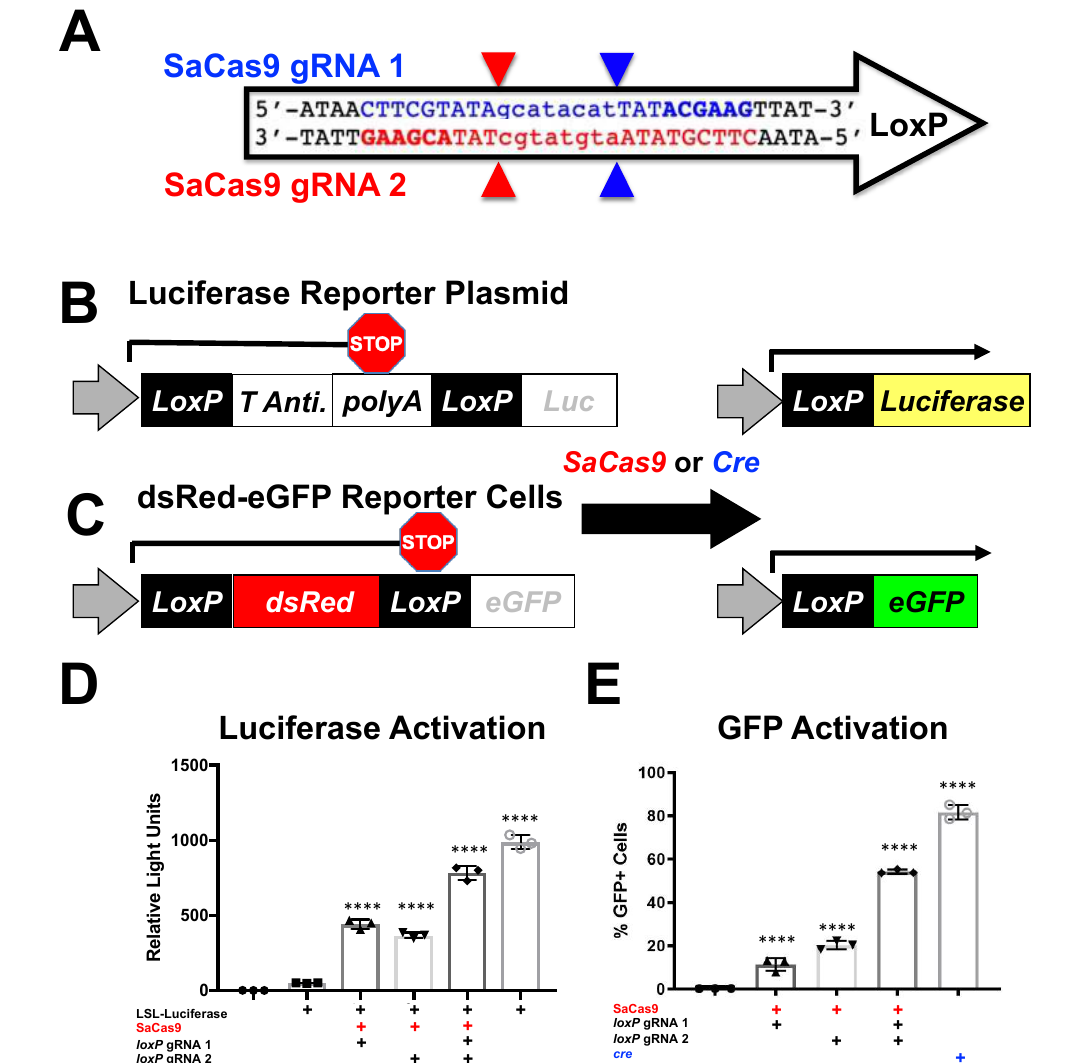
Figure 1. Gene activation through targeting lox P in vitro. ( A ) The lox P sequence is shown with key features and target sites for CRISPR SaCas9. The capitalized base pairs are the 13-base-pair palindromic regions flanking the 8-base-pair core that gives lox P its directionality. The gRNA 1 homologous strand to the guide RNA is depicted in light blue with the PAM-binding region in dark blue and bold letters and a triangle to indicate the cleavage site. gRNA 2 depicts the same in red. ( B ) This depicts the reporter plasmid p133, the LSL-Luc reporter plasmid used in D, and the general outcome when treated with SaCas9 with targeting lox P gRNAs or cre recombinase. ( C ) The lentiviral vector is used to make the Red/Green reporter cells used in ( E ) and similarly depicts the outcome when gene edited by SaCas9 or Cre. ( D ) Cells were plated into a 6-well plate and transfected at 60–80% confluency with Xfect and 2.5 µ g of the reporter plasmid was transfected to be targeted by cre or SaCas9. Groups were compared by one-way Anova and Tukey’s multiple comparison. Using this, all the groups were significant compared to other groups except between the untransfected control group and the P133 transfected group and between the individual gRNA treated groups; 95% confidence intervals are shown and the significance against the control is shown (n = 3). ( E ) The Red/Green HEK293 reporter cells were transfected with 5 µ g of plasmid. The single gRNA groups were significant compared to untransfected and the combination of gRNAs and cre was significant compared to all groups by one-way ANOVA with Tukey’s multiple comparisons. Individual gRNAs were not significant compared to each other (n = 3) (**** p < 0.00001).